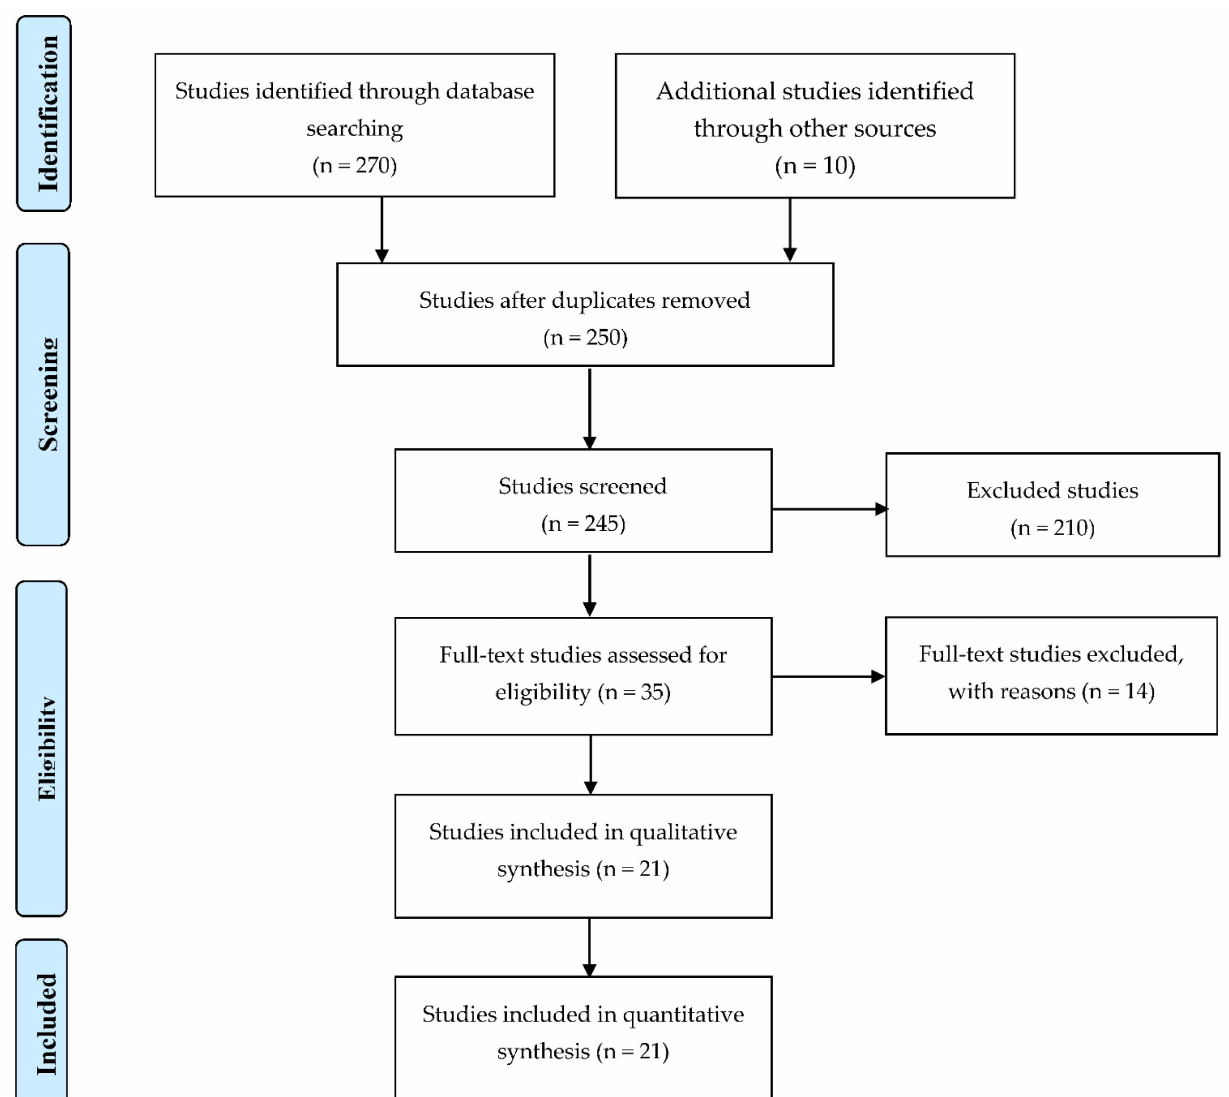
Figure 1. Collecting adequate studies on the basis of pre-defined criteria (PEDro